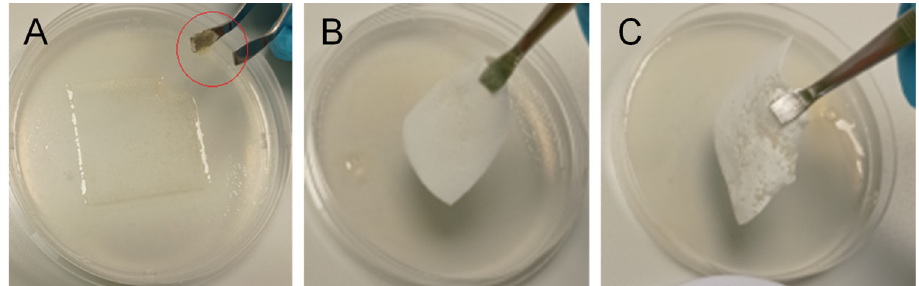
Figure 8. Repositioning of HA nonwoven textiles after their placement on a simulated wound sur- face (hydrogel): ( A ) textile could not be removed from the surface due to the loss of mechanical properties ( M W 0.8 MDa, Re 1950); fragment of the textile on the tweezers is marked by a red circle; ( B ) textile could be removed from the surface, but its edges bended ( M W 1.2 MDa, Re 1950); ( C ) textile could be removed from the surface without bending, making its repositioning possible ( M W 2.0 MDa, Re 4250). Table 5. Results of mean pore size